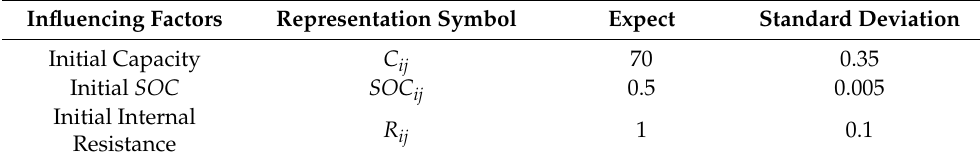
Table 1. Parameters of